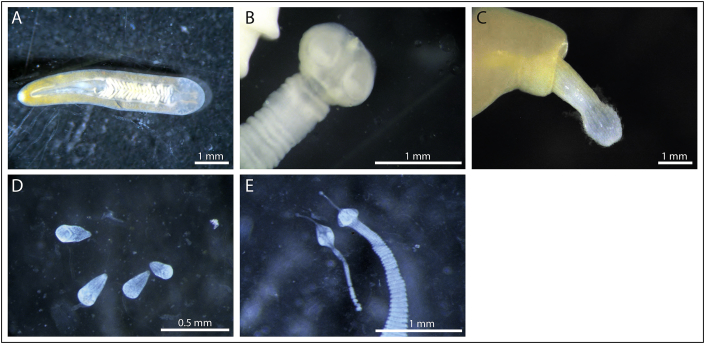
Examples of gastrointestinal parasites retrieved from common eiders in this study. (A) The trematode Notocotylus sp., (B) the cestode Lateriporus sp., (C) the acanthocephalan, Profilicollis sp. (D) microphallid trematodes, and (E) Microsomacanthus spp. cestodes.